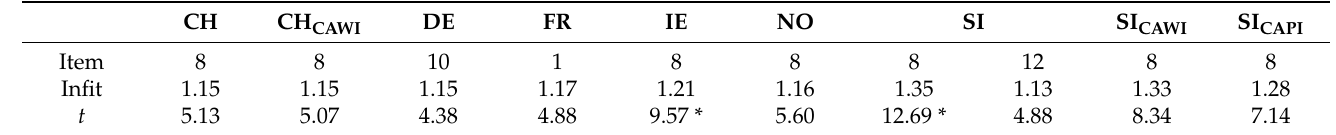
Table 10. Significantly underfitting